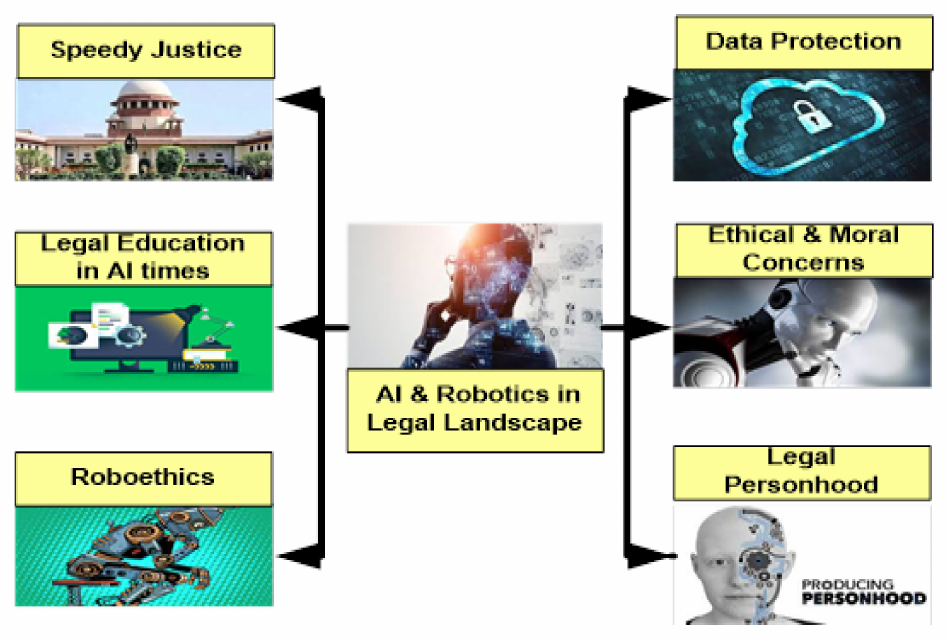
Figure 1. Concerns posed by AI &